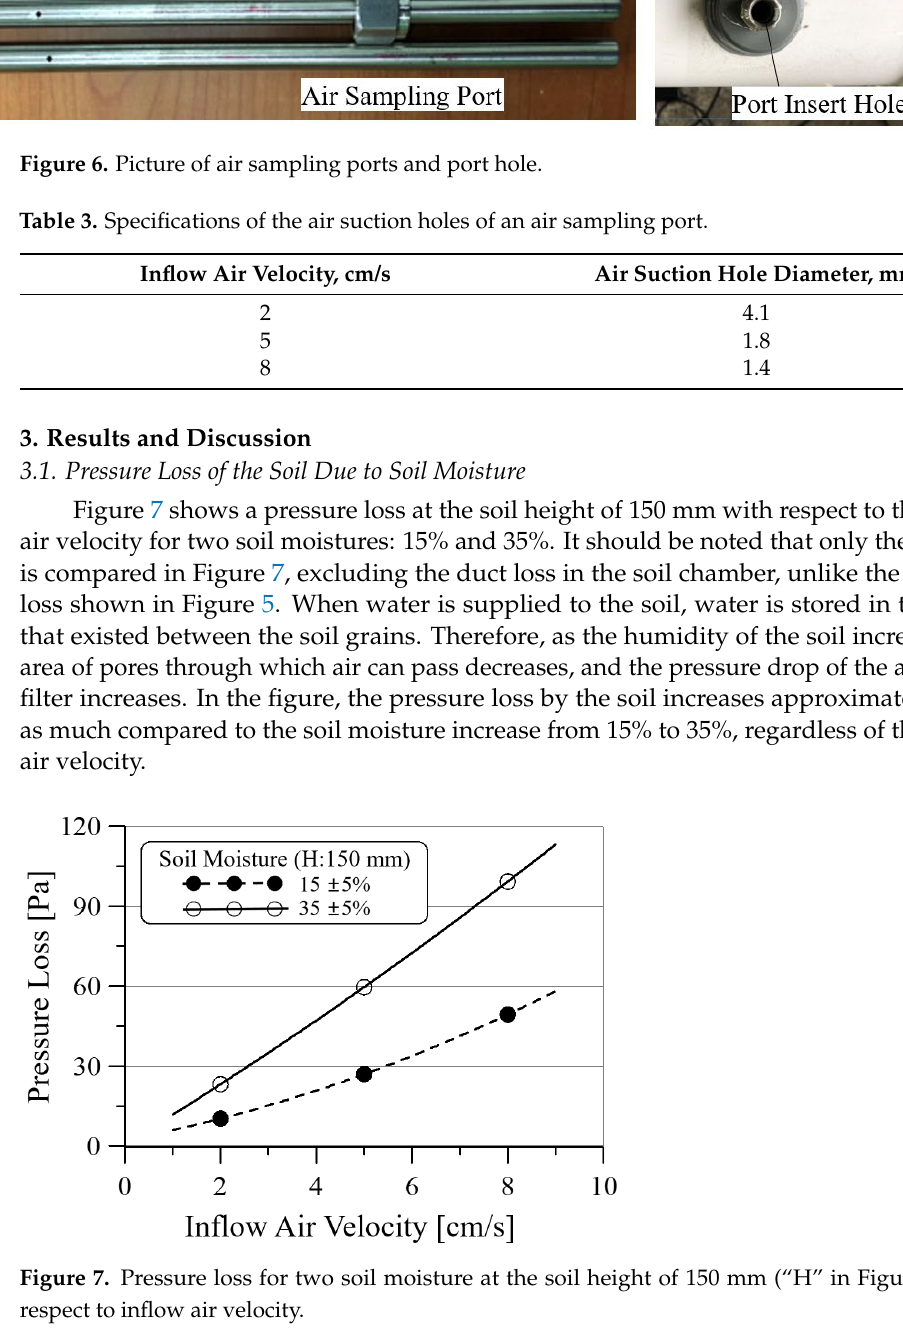
Table 3. Specifications of the air suction holes of an air sampling port.